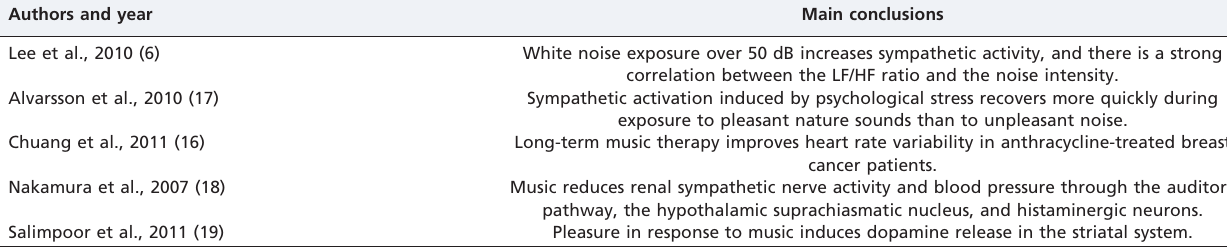
Table 1 - Main studies exploring the effects of auditory stimulation on cardiac autonomic regulation. LF/HF ratio: Low frequency/high frequency ratio; dB: